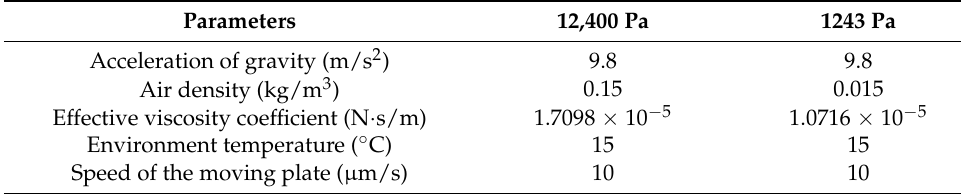
Table 3. Simulation parameter settings under low pressures.